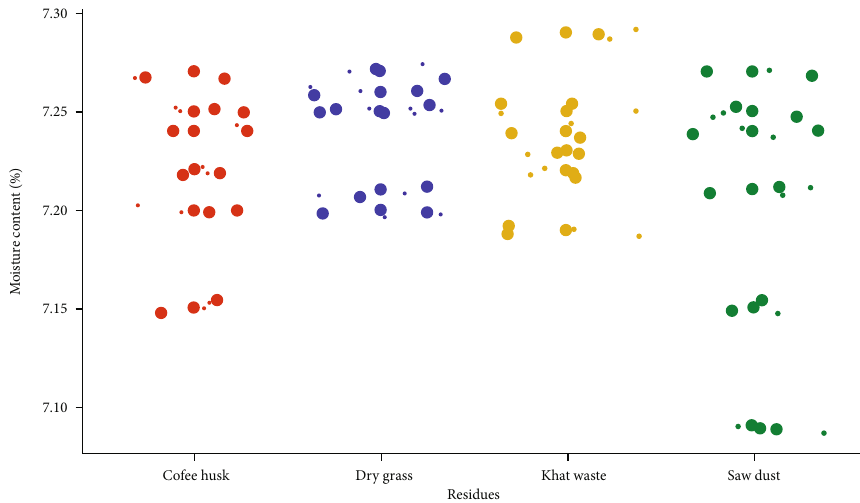
Figure 2: The e ff ect of residues on percentage of produced briquette moisture content.